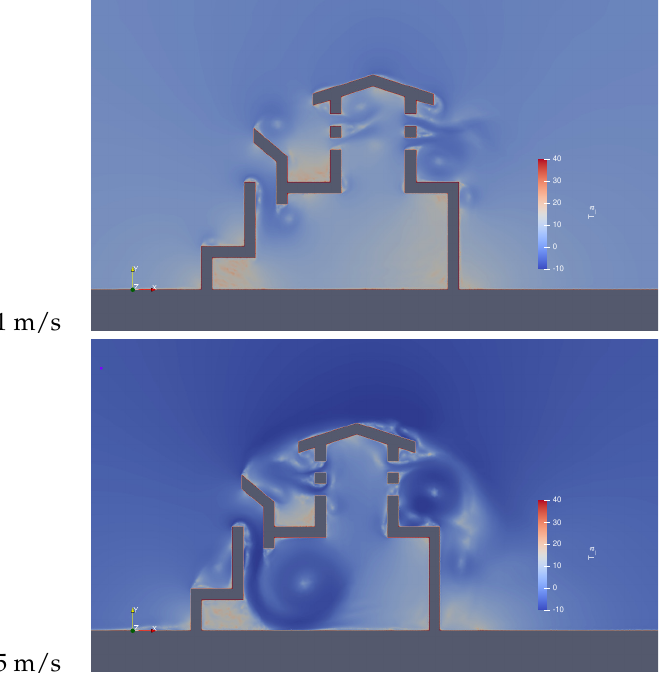
Figure 20. Wind tower 1. Comparative apparent temperature field obtained with the full NS with U ∞ = 1 m/s and U ∞ = 5 m/s.